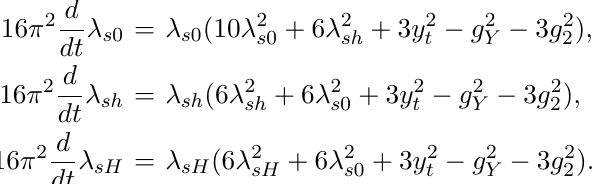
; (cid:21) and (cid:21) s 0 sH sh